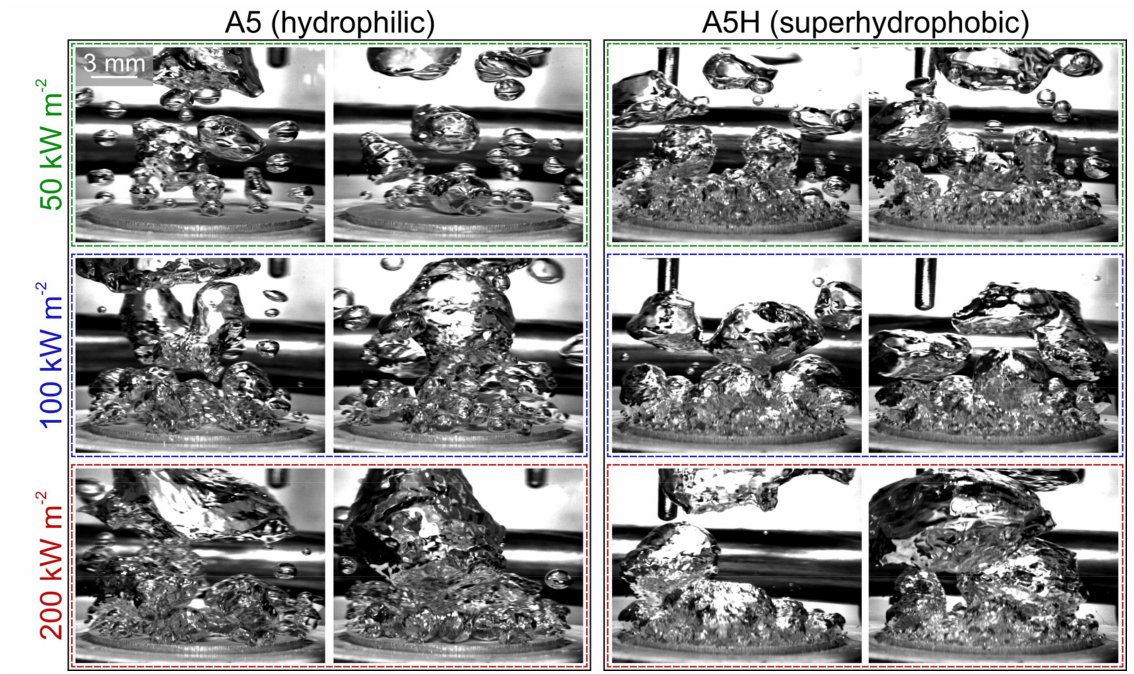
Figure 10. High speed snapshots of the boiling process on the A5 ( left column ) and A5H ( right column ) surfaces at three different heat fluxes during boiling of